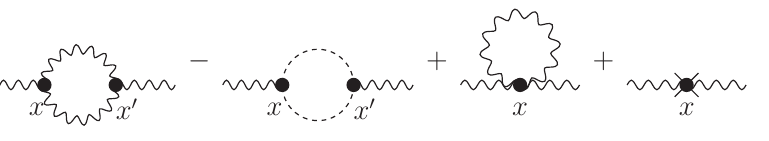
Figure 1: Diagrams contributing to the one loop graviton self-energy, shown in the same Figure 1. Diagrams contributing to the one-loop graviton self-energy, shown in the same order, left to order, left to right, as the four contributions to (15). Graviton lines are wavy and ghost right, as the four contributions to (15). Graviton lines are wavy and ghost lines are lines are dashed.